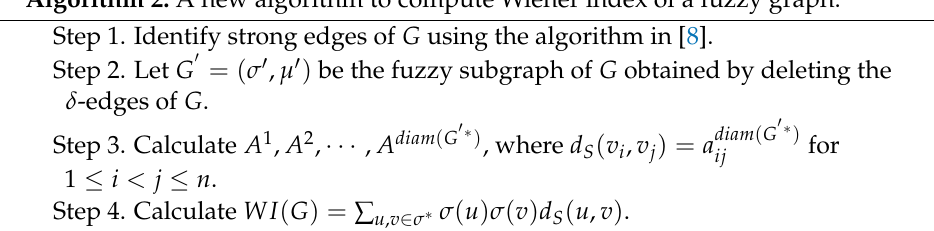
Algorithm 2: A new algorithm to compute Wiener index of a fuzzy graph.